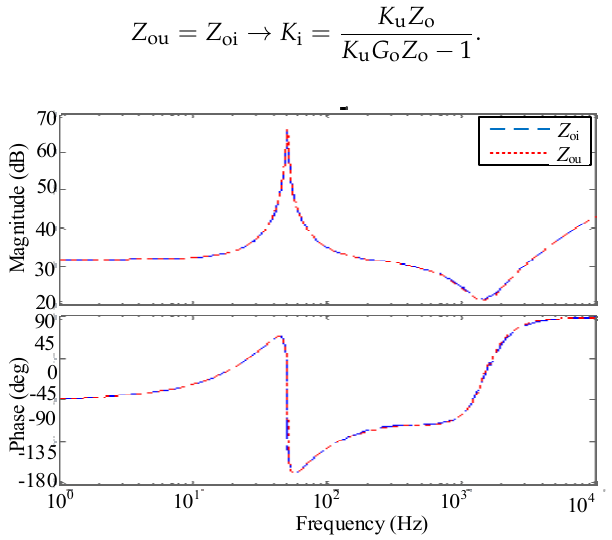
Figure 7. Bode plots of output impedance with two basic impedance reshaped methods.